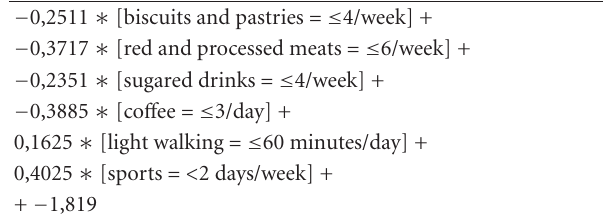
Table 5: Equation for GDM = 1 when applying logistic regression using the transformed variables as independent